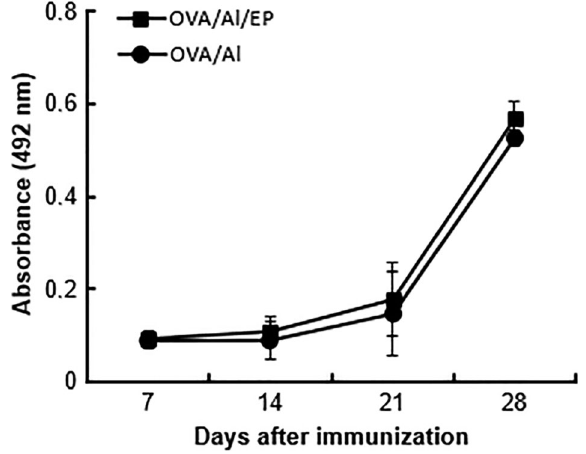
Figure 2. Levels of anti-ovalbumin (OVA) IgG2c during the study period. Two groups of mice (3 – 4/group) were subcutaneously immunized with OVA/Alhydrogel (Al) and boosted at day 21. The mice were orally treated with enalapril (EP) or were left without treatment. OVA-speci fi c IgG2c levels were determined by ELISA using 1:1000 diluted serum. Data are reported as means and represent 2 independent experiments. *P=0.0006, one-way ANOVA followed by the Tukey ’ s